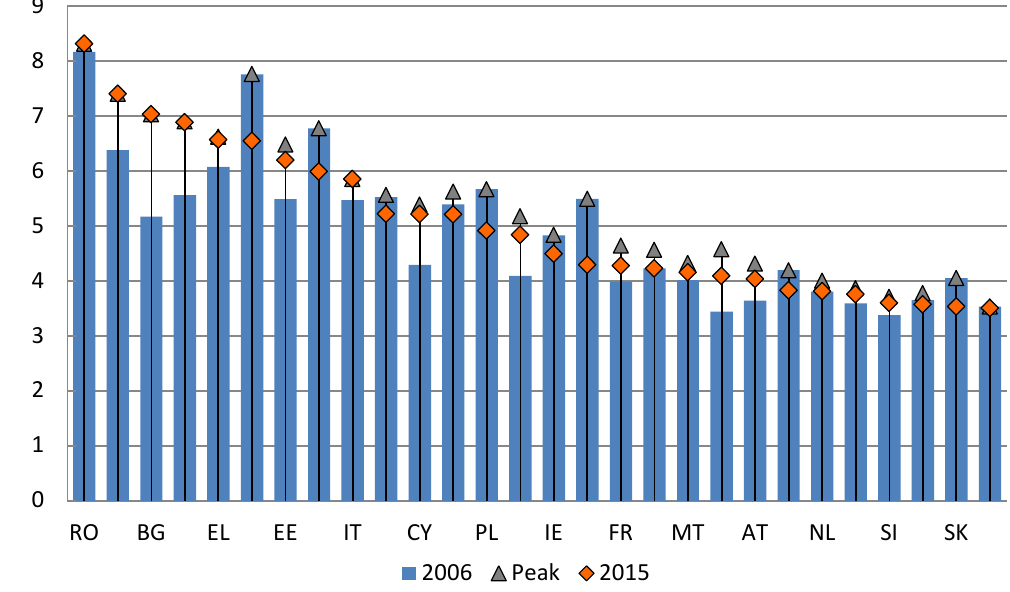
Figure 5. S80/S20 ratio in the EU-28 countries (2006, 2015, and period peak). Source: Own elaboration based on statistics from Eurostat. Notes: (i) Countries appear ranked according to the highest S80/S20 ratio in 2015. (ii) Croatia's data correspond to 2010 instead of 2006; Romania's data correspond to 2007 instead of